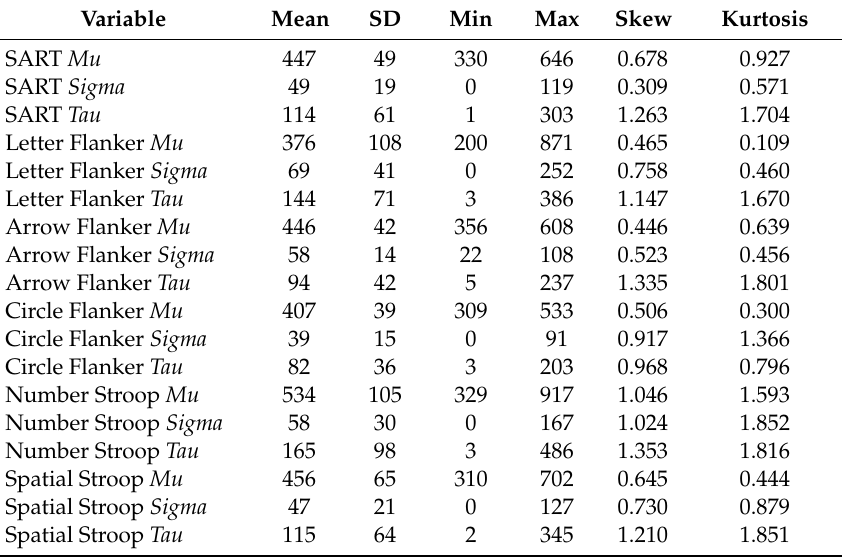
Table 5. Descriptive statistics for ex-Gaussian